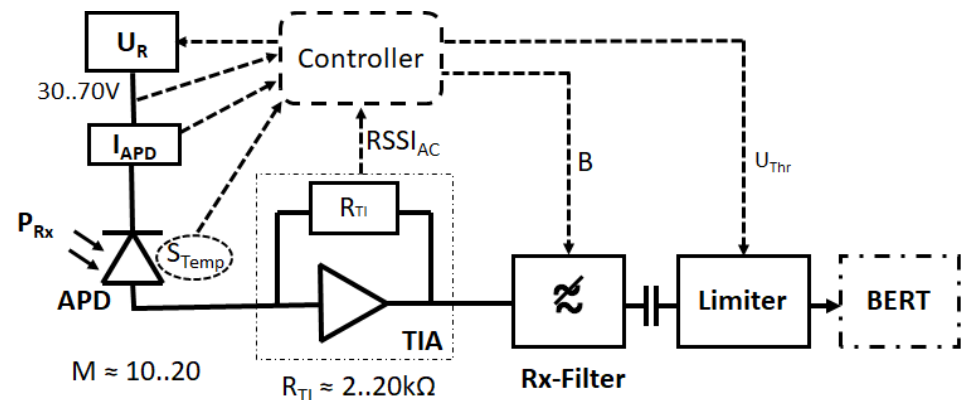
Figure 1. Practical InGaAs-APD receiver diagram for high-speed free-space optical (FSO) commu- nications.